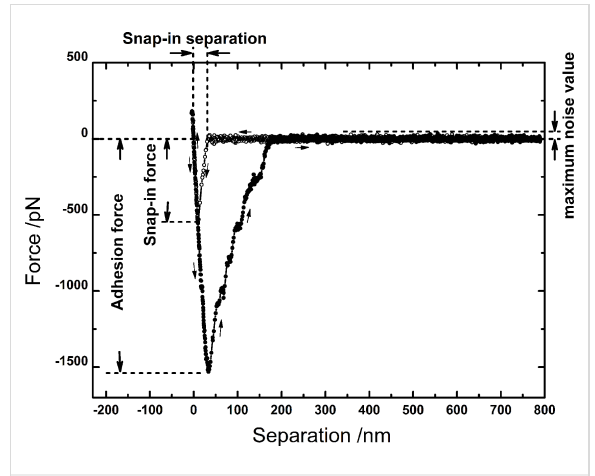
Figure 2: Typical force/distance curve, taken with a single S. carnosus probe on an OTS-covered (hydrophobic) Si wafer. By analyzing the curve, the adhesion force, the “snap-in force” and the “snap-in sep- aration” can be obtained, the description of the latter is given in the text. The arrows indicate the direction of motion of the piezo drive.